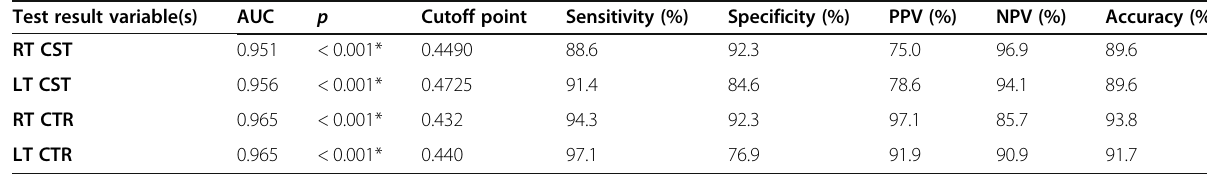
Table 4 The overall sensitivity, specificity, PPV, NPV, and AUC of FA values in CP and control group in CST and CTR Test result variable(s)